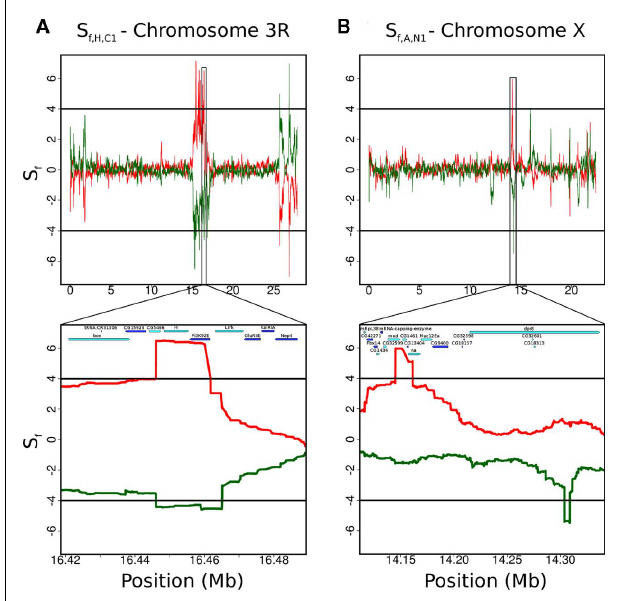
FIGURE 5 | Comparison of S f statistics in two different datasets. The plots show the S f statistic for two biological replicates of case (one in red, the other flipped, in green) versus control.The black lines (at 4 for the red curve and − 4 for the green curve) represent a threshold corresponding to a 1% FDR. (A) The S f signal on the 3R chromosome shows strong concordance between the two hypoxia-tolerant populations, H1 (red) and H2 (green, flipped).The control in both cases is the C1 population.This implies that the same series of selective sweeps has occurred in both populations. (B) The two populations selected for accelerated development, A1 (red) and A2 (green, flipped), do not show strong concordance – even the significant regions that appear on a broad view to be colocated (such as around 14Mb on chromosome X) do not match up.The control in both cases is the N1 population.This could be due to weaker selection pressure, lower coverages, or differences in generation times, among